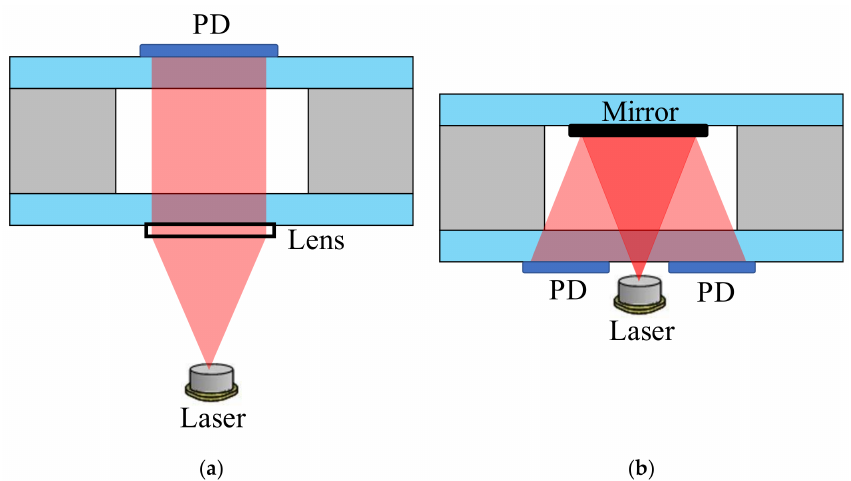
Figure 1. Optical configurations of ( a ) single light passing through the cell cavity and ( b ) round-trip light pass with folded optics.